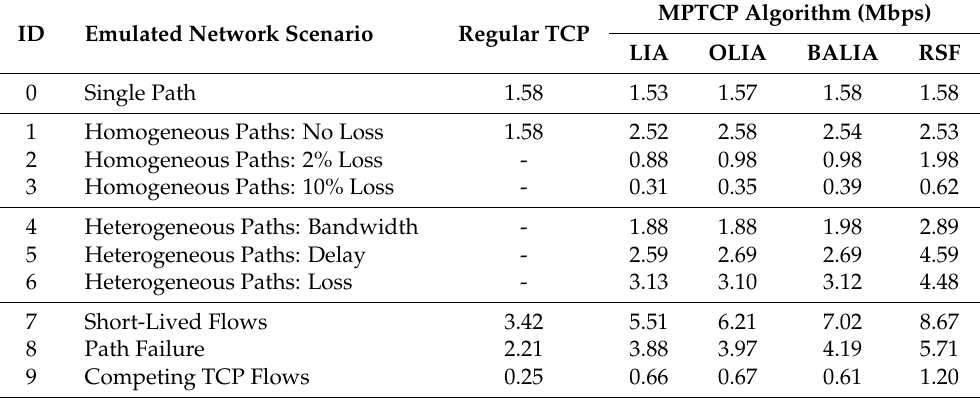
Table 2. Summary of the throughput results from the network emulation